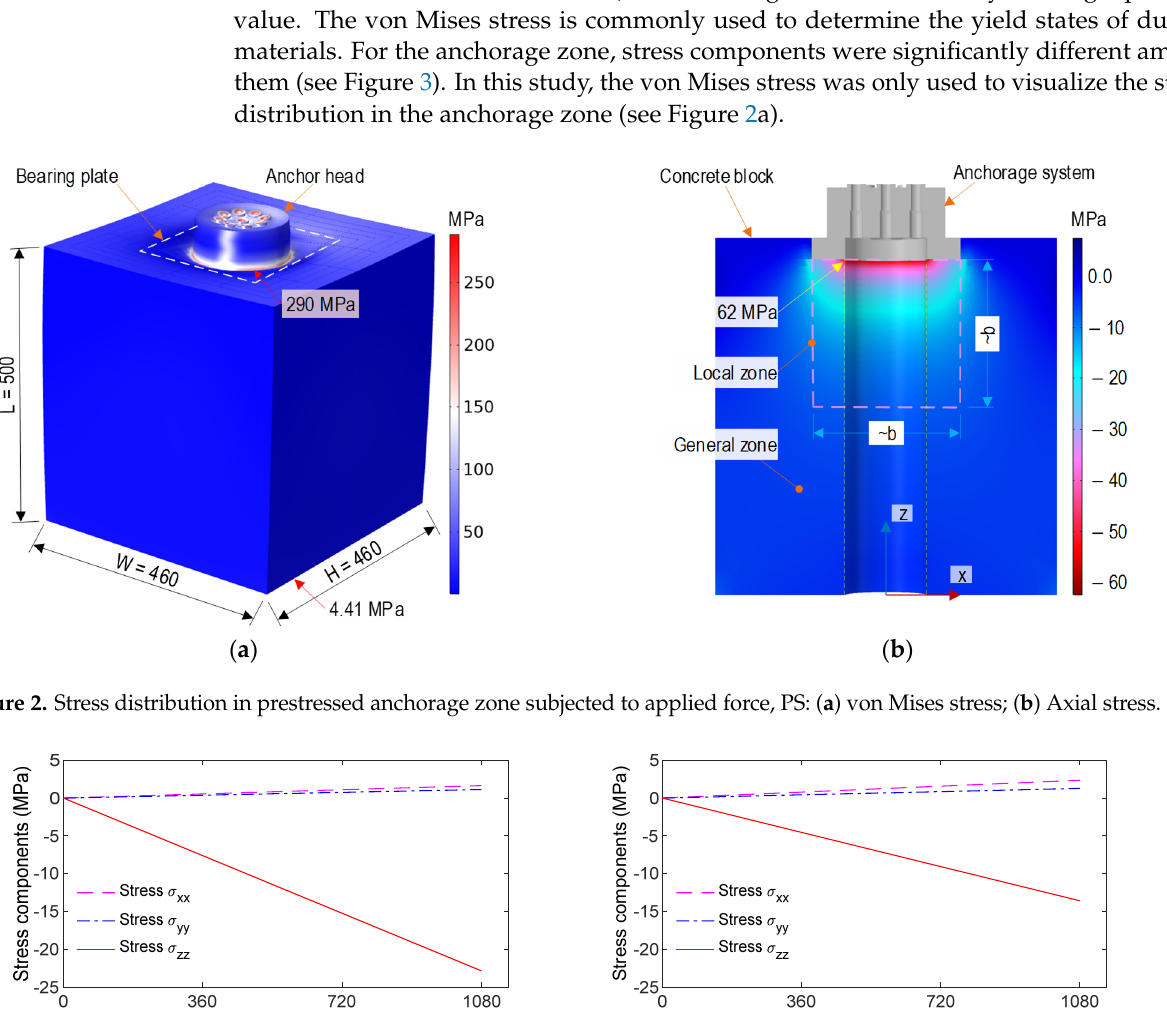
Sensors 2021 , 21 , x FOR PEER REVIEW